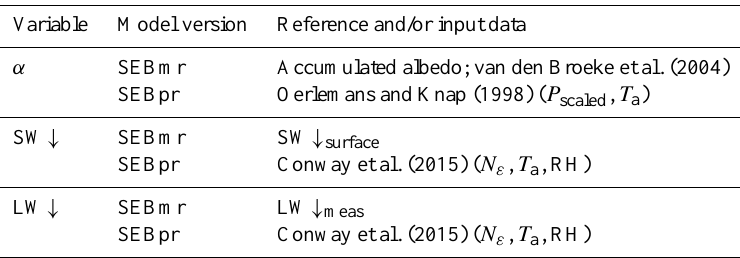
Table 2. Configuration of SEBmr and SEBpr, showing input data and references used in the calculation of radiation terms in each configu- ration.